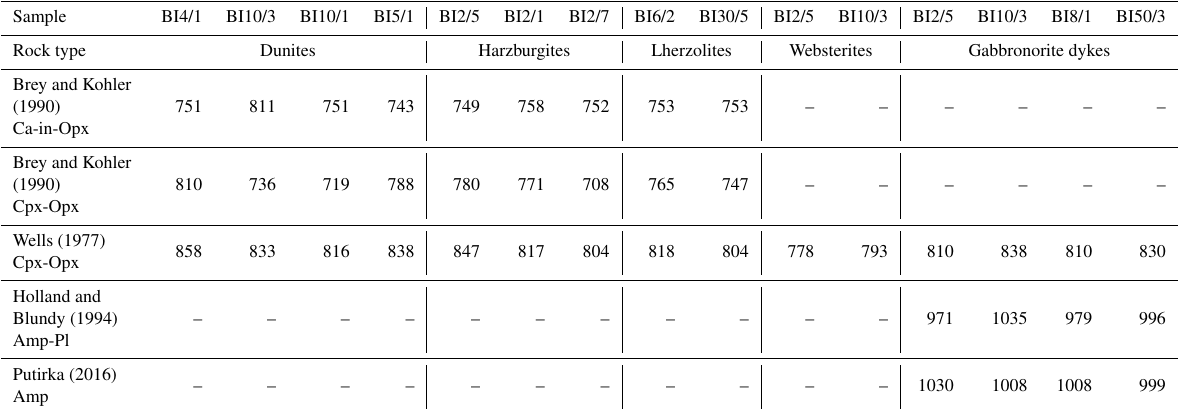
Table 11. Temperature estimates ( ◦ C) obtained for the selected rocks of the Rocca d’Argimonia sequence. A confining pressure of 0.8GPa was assumed in the calculations, in agreement with pressure estimates reported by Demarchi et al. (1998) for the base of the Ivrea Mafic Complex. The method of Putirka (2016) was applied using Eq.